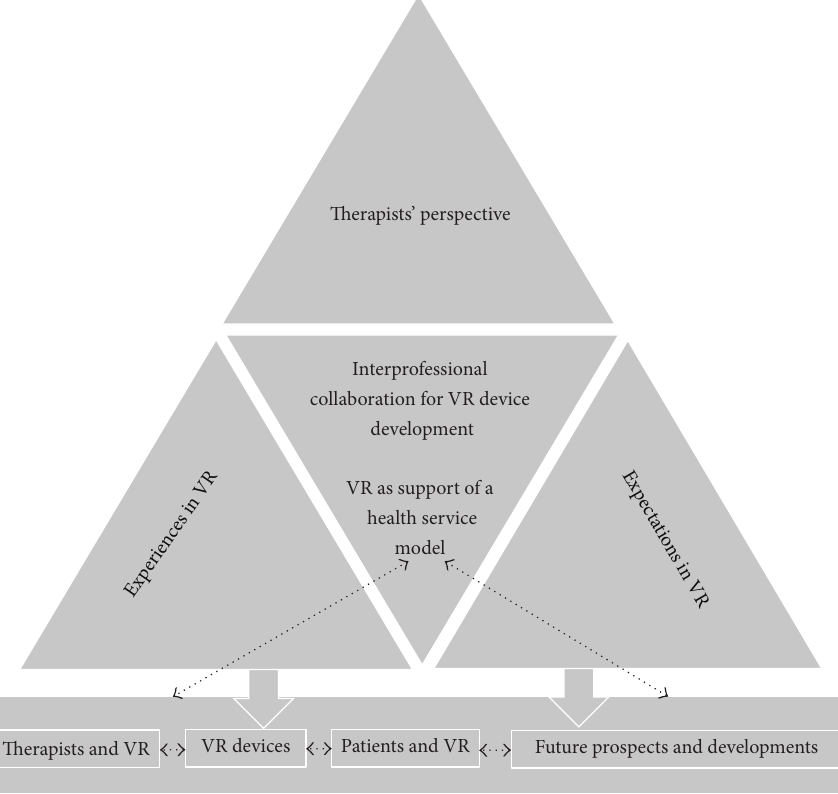
Figure 3: Relationship between research question, first-level categories, and study conclusion. VR: virtual